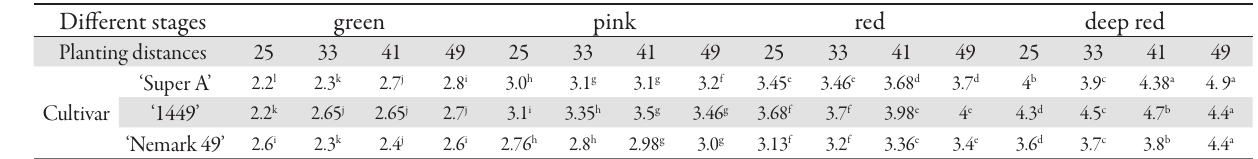
Tab. 2. Comparison of interaction between variety, row spacing and different stages of maturity for ascorbic acid Different stages green pink red deep red Planting distances